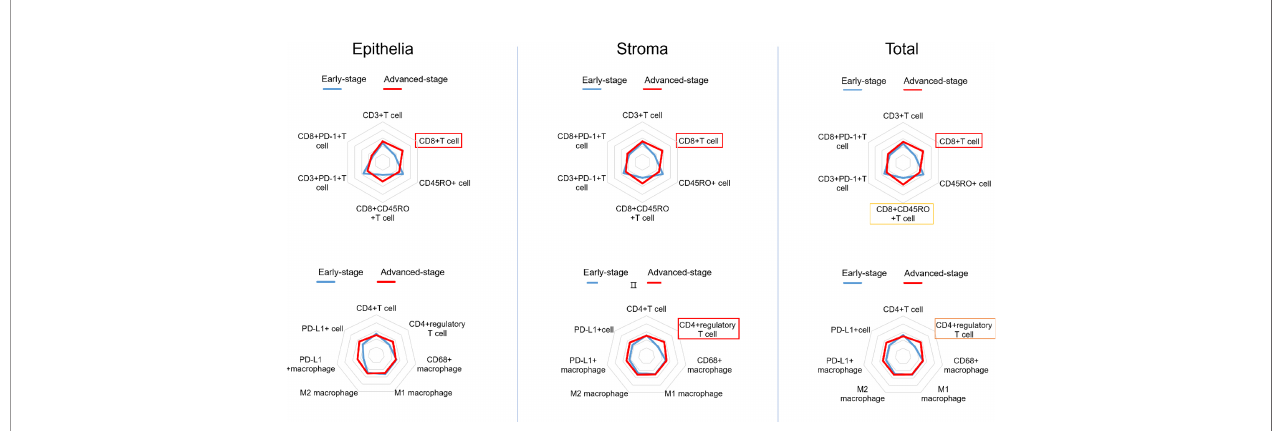
FIGURE 1 | Radar plots showing the average percentile of each immune cell subset in dMMR CRCs (early stage vs. advanced stage). The density of immune cells was segmented as a whole and separately and analyzed in three arrays: epithelial regions (left), stromal regions (middle), and total regions (right). The frames indicate whether each variable is statistically signi fi cant ( p <